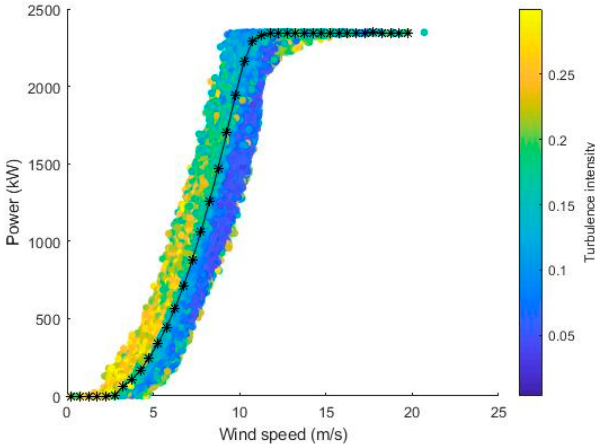
Figure 7. Power curve for the study turbine, derived using ten-minute SCADA data from 1 July to 15 October 2018. The 10 minutes values are shown in dots, and the color scale represents 10 minutes average turbulence intensity measurement on top of the nacelle. The binned averages are in black.